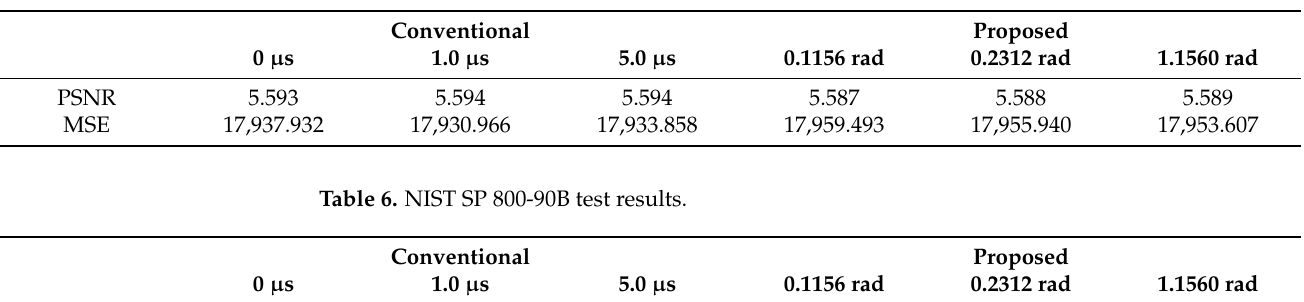
Table 5. Comparison data of image quality using conventional and proposed methods.